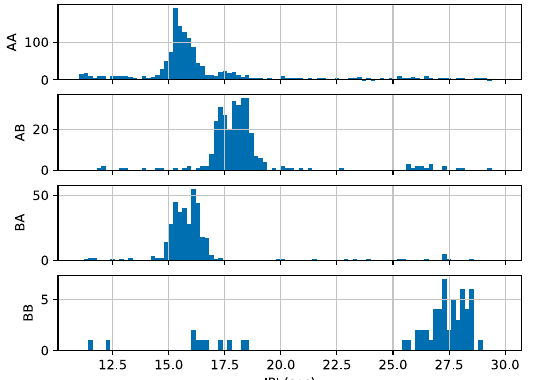
Figure 6. Histogram of the IPI for each type sequence (or bi-gram).